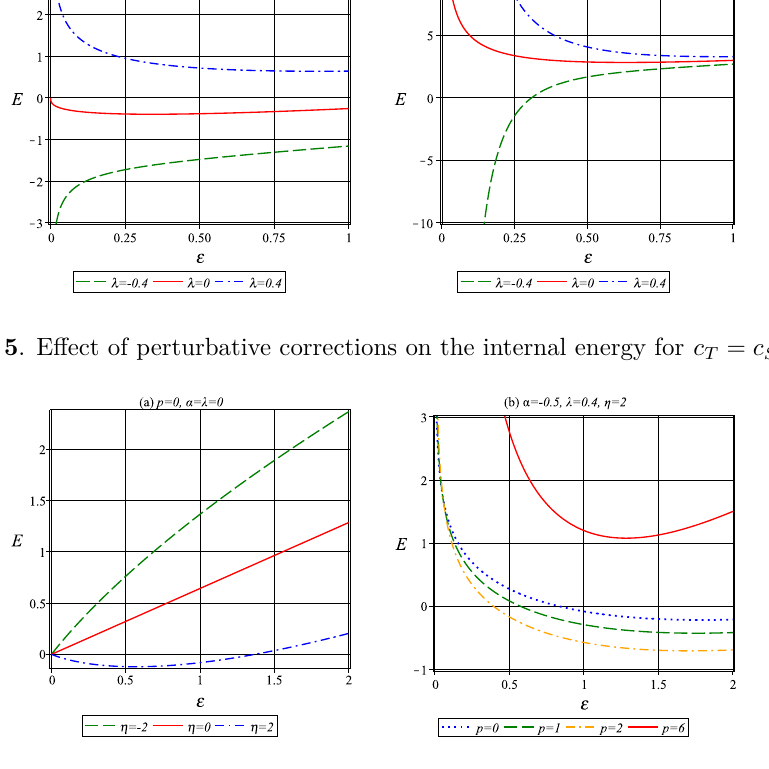
Figure 6 . Effect of non-perturbative corrections on the internal energy for c T = c S = 1 . Cyan lines are corresponding to α = λ = η = 0 for p = 0 (dotted) and p = 6